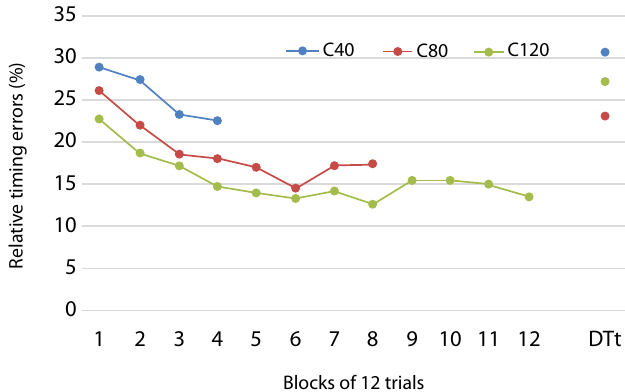
Figure 10 . Relative timing errors ( A E prop) in acquisition and trans- fer test (Tt).